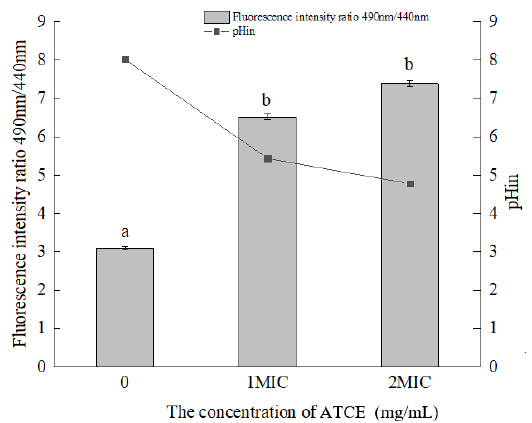
Figure 3. Differences in the intracellular pH (pHin) of S. aureus ATCC 13565 after treatment with ATCE at 0, 1, and 2 MIC. Values denote the means of triplicate measurements. Error bars represent standard deviation ( n = 3). Different lowercase letters (a, b) represent significant differences ( p < 0.05).